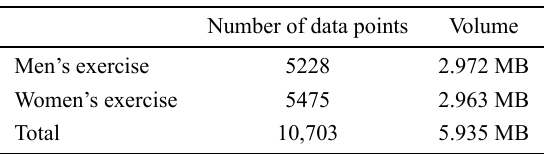
Table 2. Men’s and women’s COVID-19 exercise-related datasets.